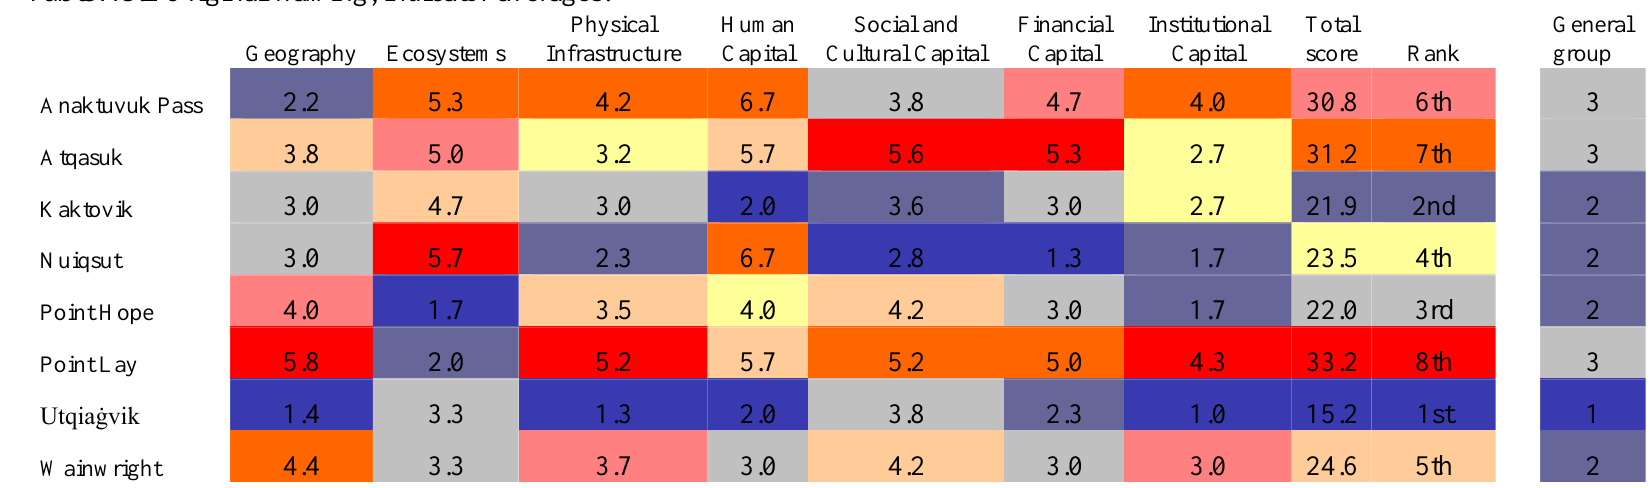
Table A3.1 Original framing, indicator averages.